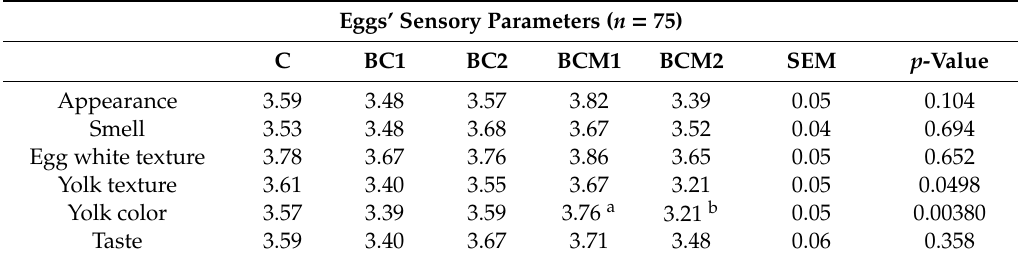
Table 8. Sensory traits of hardboiled eggs after biochar supplementation.